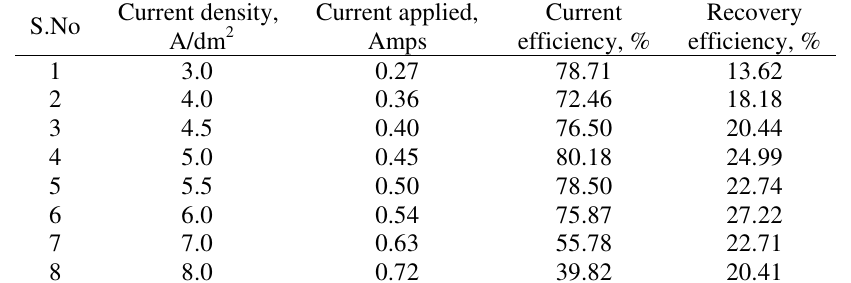
Table 2. Effect of current density on metal recovery efficiency with unmodified